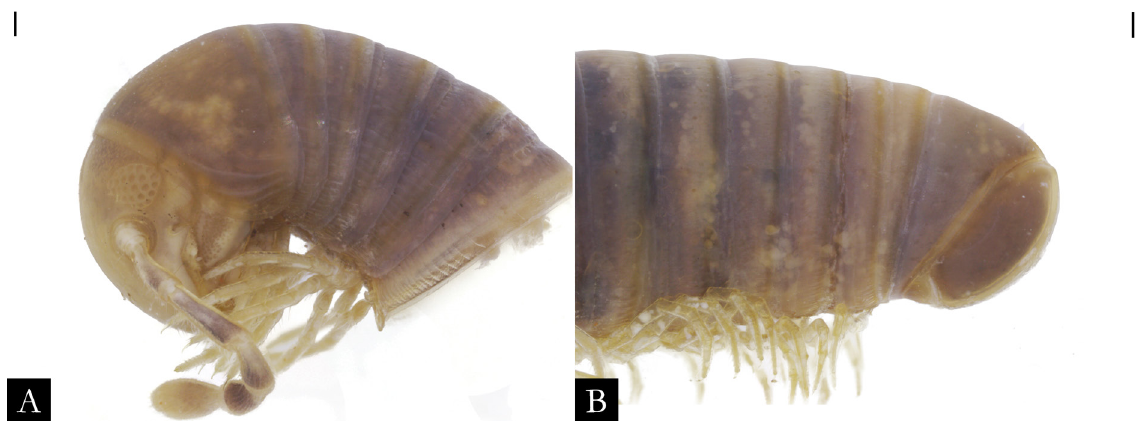
Fig. 143. Pseudonannolene xavieri Iniesta & Ferreira, 2014, ♂ (MNRJ 30148), in lateral view. A . Anterior region. B . Posterior region. Scale bars = 0.2